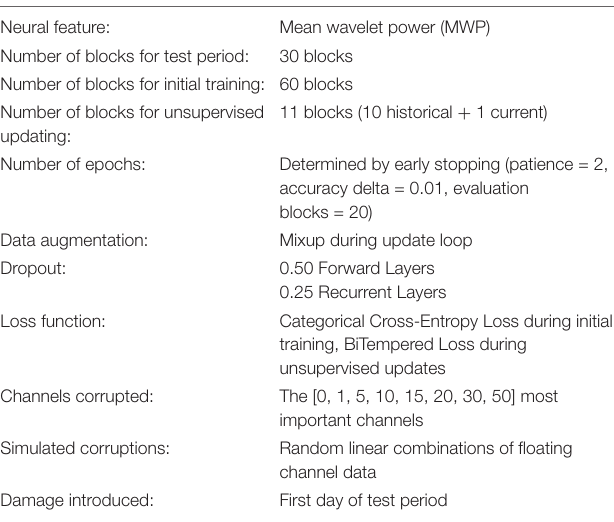
TABLE 1 | Dataset used for all experiments and training parameters common for all DNN models. Neural